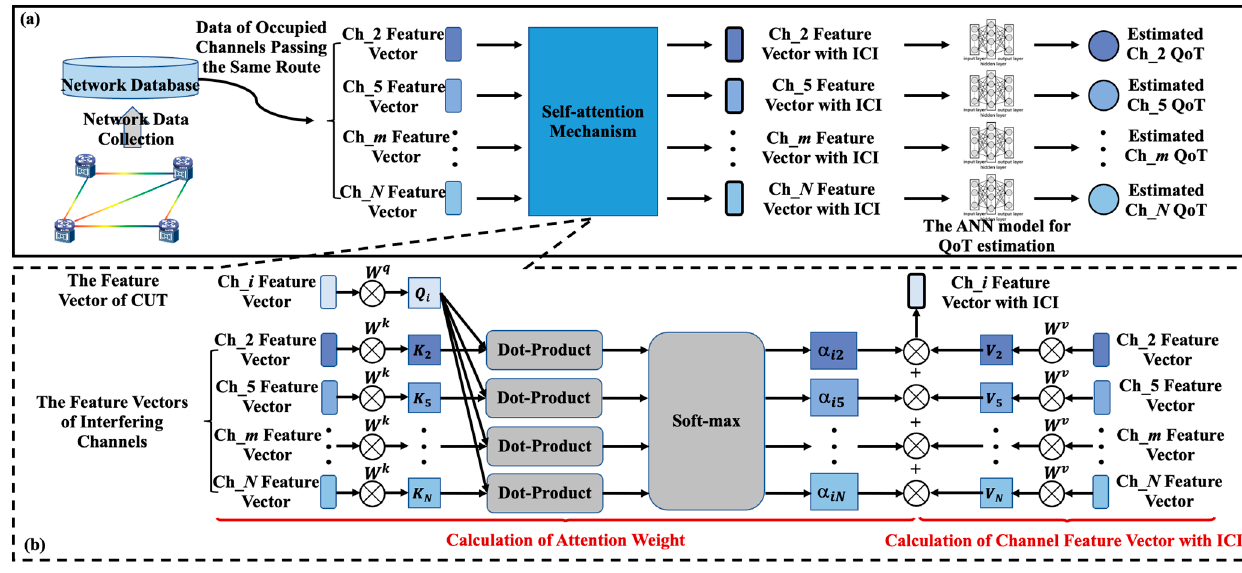
Figure 1. ( a ) Schematic diagram of self-attention mechanism-based multi-channel QoT estimation scheme; ( b ) process of self-attention mechanism.